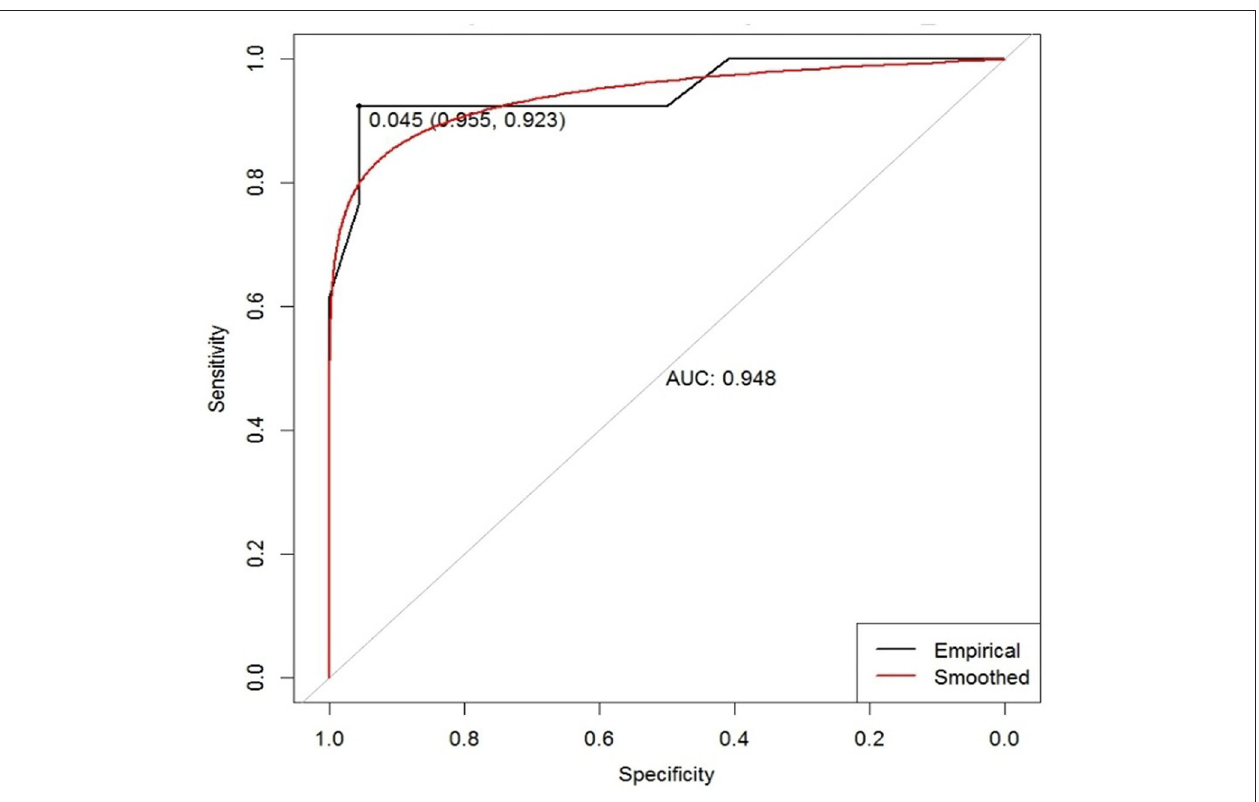
FIGURE 3 | ROC curve based on the difference in the C-ApEn of Cu-FPu under unaffected pain stimulation conditions for predicting patient outcome in UWS. AUC, area under the curve. The empirical line is mapped to the graph according to the actual data, and the smoothed line is the fitted curve. The marked points are the optimal solution given by the